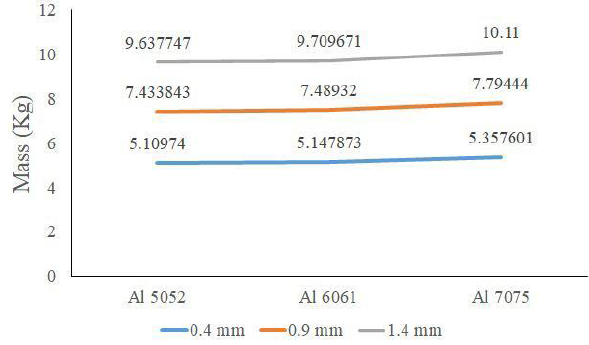
Figure 22: Relationship between chassis thickness and material type with the chassis mass